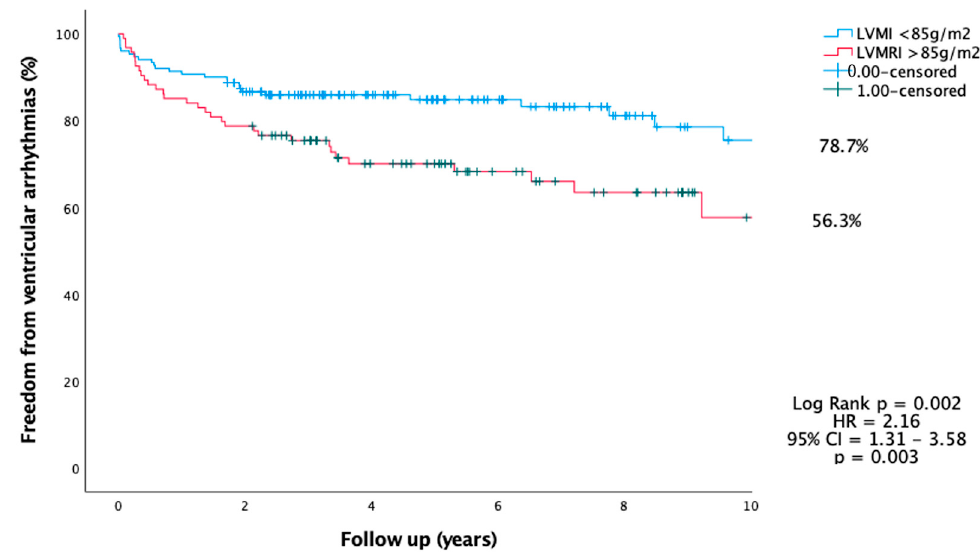
Figure 8. Kaplan–Meier analysis of LV mass and freedom from ventricular arrhythmia over a follow-up of 10 years.